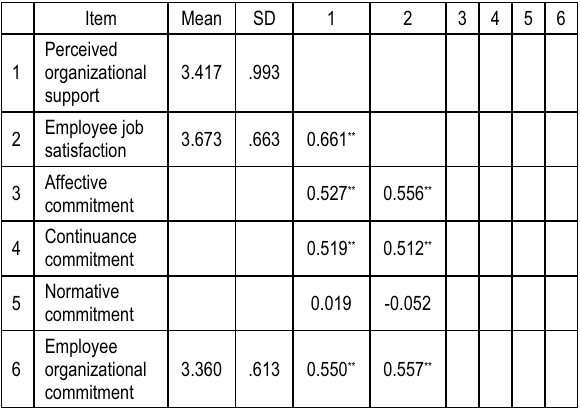
Table 3. Descriptive analysis and correlations between perceived organizational support, employee job satisfaction and organizational